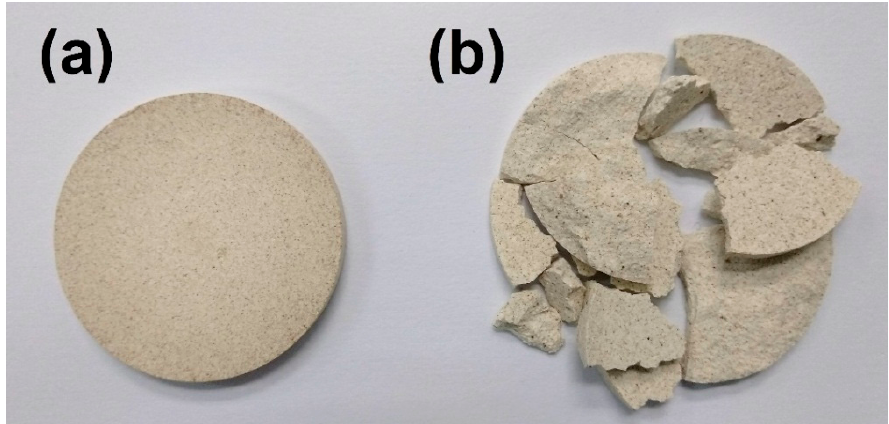
Figure 8. Expansion curves of cenospheres and heat-treated cenospheres at temperatures from 100 °C to 1000 °C.